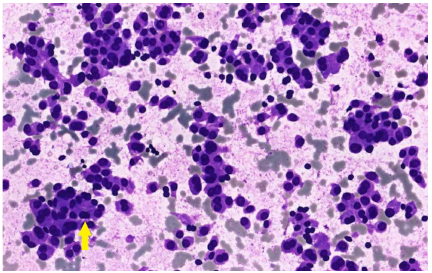
Figure 4: (400x, Giemsa). FNA of thyroid nodule. There is a hypercellular smear with atypical cells and small follicle indicated by a yellow arrow. Other cells have a oncocytic aspect.